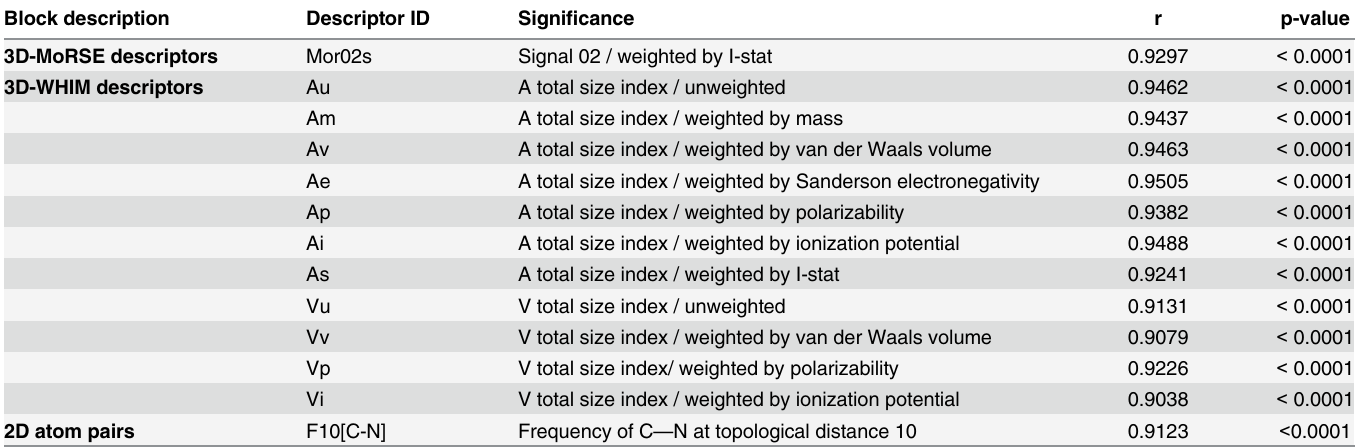
Table 2. Molecular descriptors highly correlated with OCT1 activity inhibition for BIMs (r >